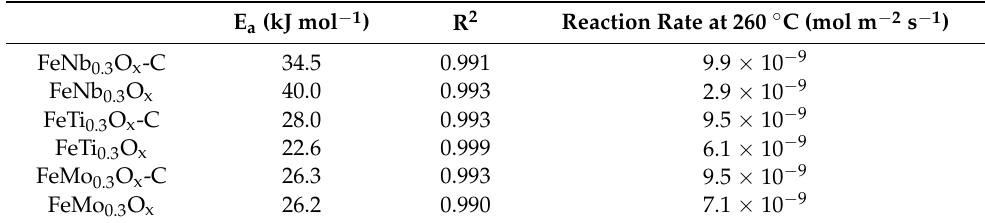
Figure 2. Arrhenius plots of the reaction rates over all the FeM 0.3 O x -C and FeM 0.3 O x (M = Nb, Ti, Mo) samples. Reaction conditions: [NO] = [NH 3 ] = 500 ppm, [O 2 ] = 5 vol %, N 2 balance, with the NOx conversion below 25%. Table 1. Activation energy and reaction rate at 260 °C of all the FeM 0.3 O x -C and FeM 0.3 O x (M = Nb, Ti, Mo) samples.